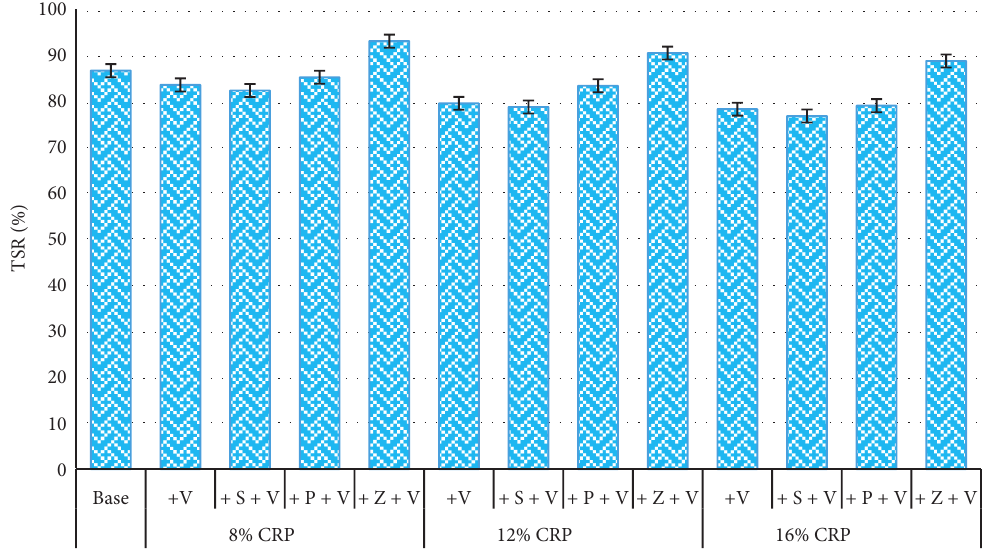
Figure 6: TSR results of various mixtures in the ITS test.